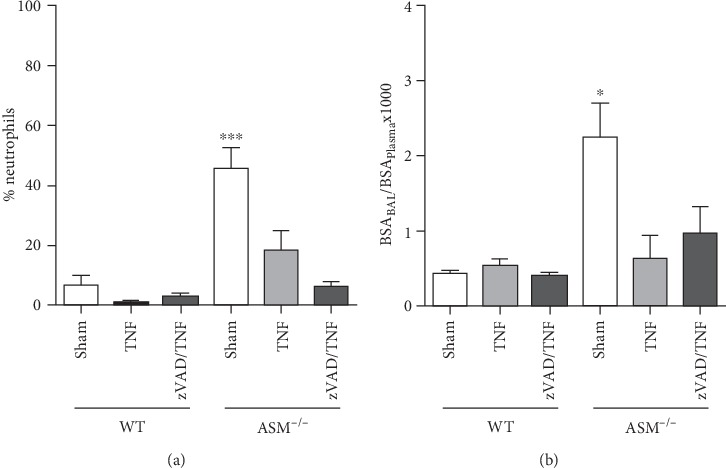
Microvascular permeability. (a) Intra-alveolar neutrophils were assessed by cytospin preparation of the bronchoalveolar lavage (BAL) fluid. (b) Bovine serum albumin (BSA) was injected into the tail vein after 105 min of ventilation. The ratio between BAL and plasma BSA levels is shown as an indicator for microvascular permeability. Data are shown as mean + SEM with n = 4 in the group WT sham, n = 6 in ASM−/− sham, and n = 5 in the other groups. ∗p < 0.05, ∗∗∗p < 0.001.